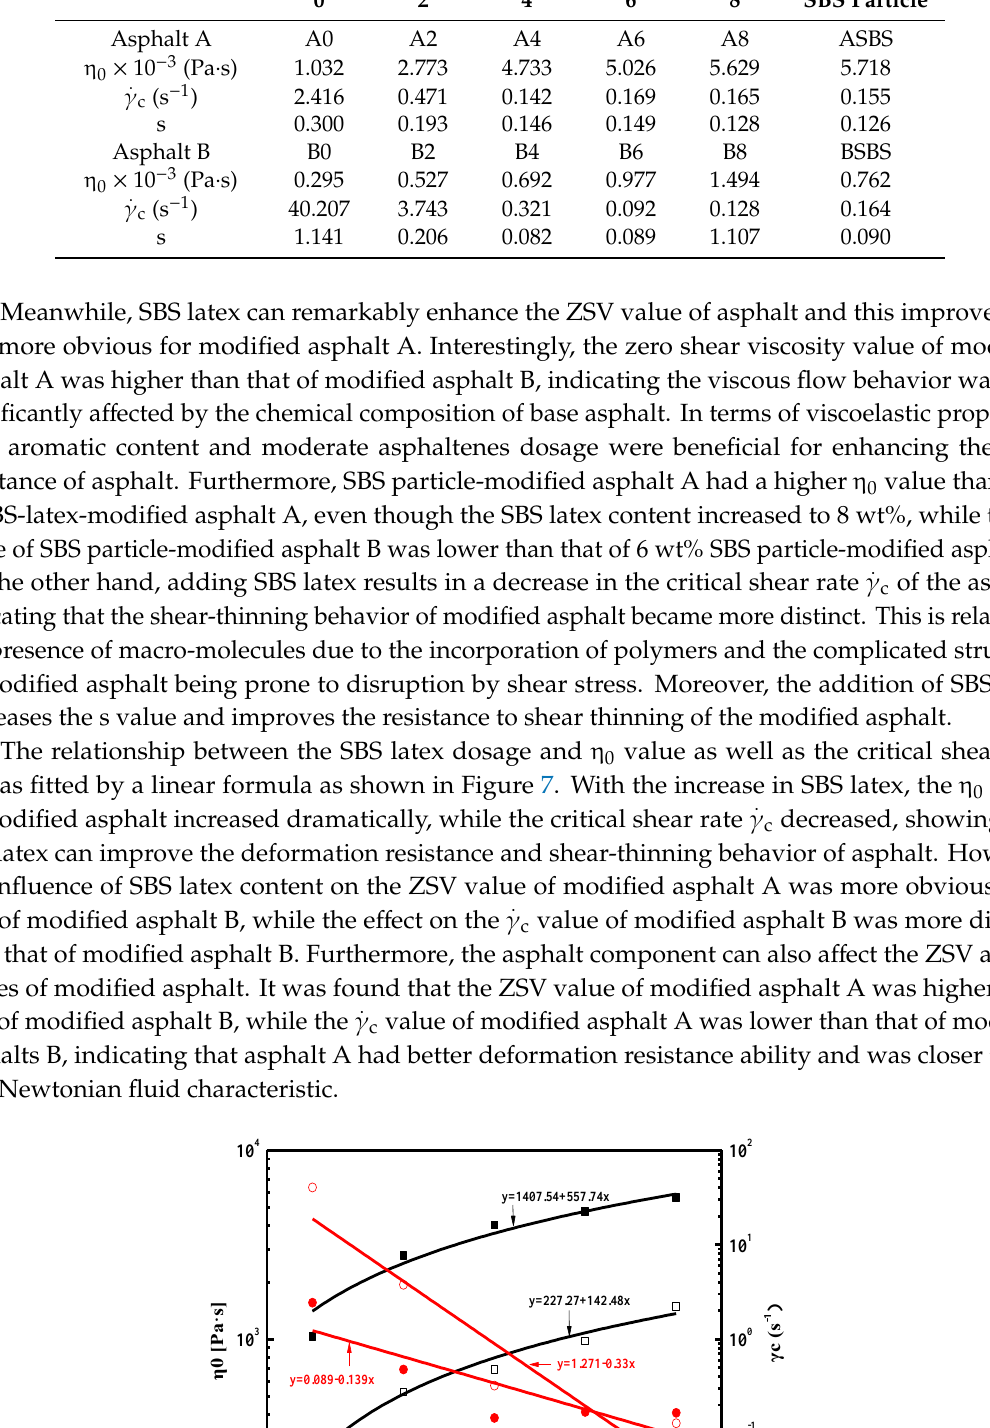
Table 3. The results calculated from the Carreau model at 60 ◦ C of all studied samples.